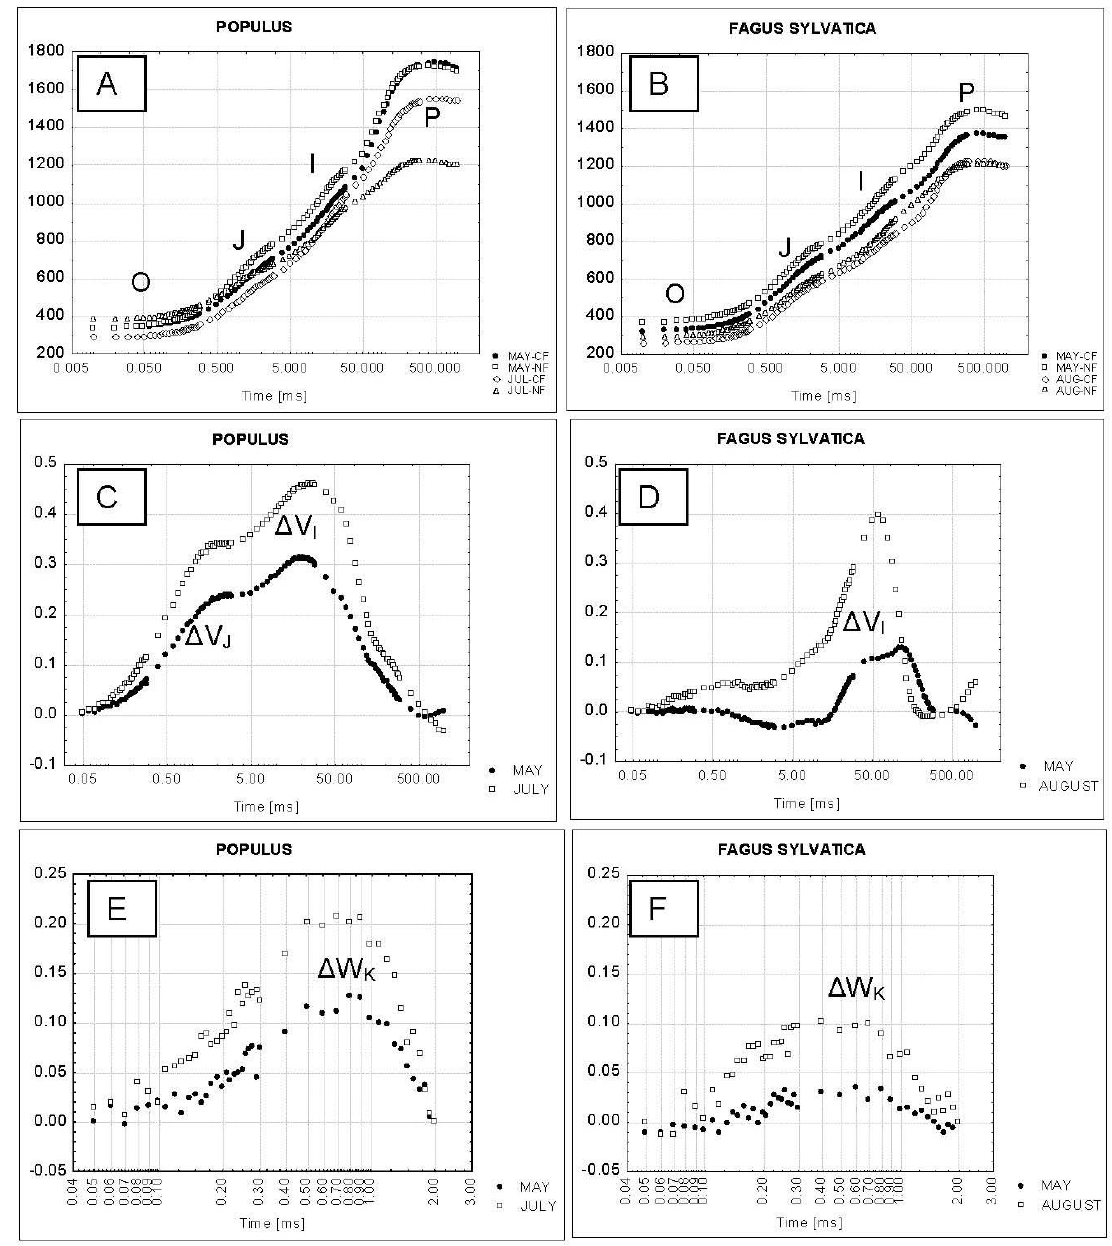
FIGURE 5 . (A, B) Original transient mean curves, per month and experimental conditions (CF and NF). The O-J-I-P steps are labeled. (C, D) ΔV curves, obtained by subtraction from the original fluorescence transients (NF-CF) normalized between F 0 and F M and multiplied by 4. (E, F) ΔW curves, obtained by subtraction from the original fluorescence transients (NF-CF) normalized between F 0 and F J and multiplied by 4. Assessment dates: May 30, before the onset of symptoms; July 24 (poplar) and August 30 (beech), when symptoms were fully